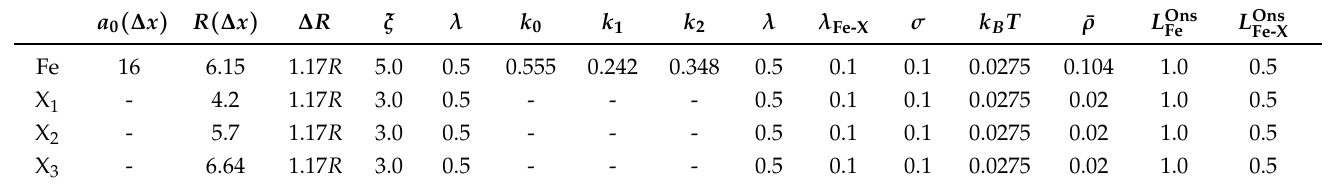
Figure 3. Pairwise interaction potentials used in this work in Fourier space: ( a ) short range interaction potential ˆ θ α ( k ) for Fe, X 1 , X 2 and X 3 atoms, ( b ) long range interaction potential ˆ W LR (red) for X = X 1 , X 2 and X 3 using parameters of Table 1. Table 1. Parameters used in this work for QA